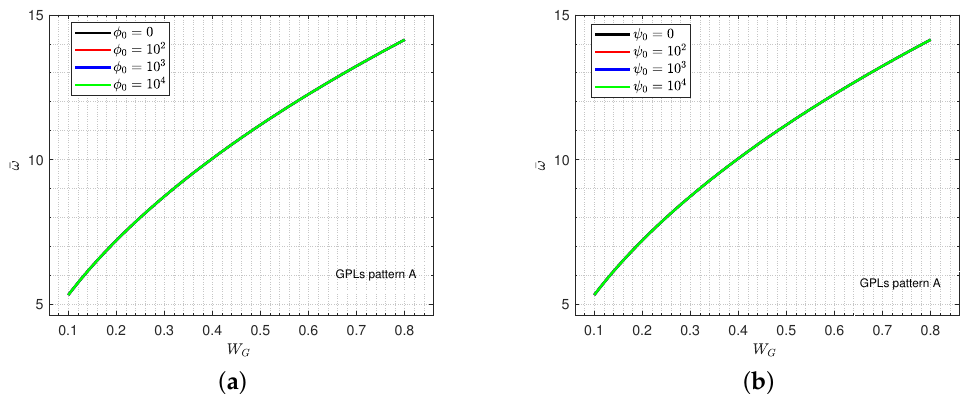
Figure 9. Wave frequency ¯ ω (THz) of the FG GPLs-reinforced sandwich nanocomposite piezoelectro- magnetic plate with a honeycomb core versus the graphene weight fraction W G for various values of